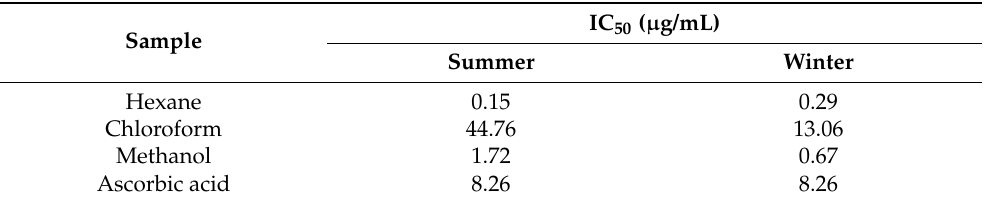
Table 4. IC 50 values showing the antioxidant activity of the various solvent extracts from summer and winter leaves of C. macrocarpa